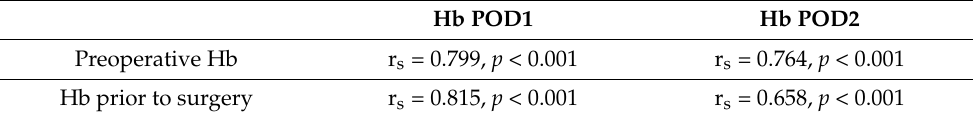
Table 3. Correlations of preoperative hemoglobin levels and hemoglobin levels prior to tourniquet inflation with Hb levels on postoperative day 1 and postoperative day 2. Hb POD1 Hb POD2 Preoperative